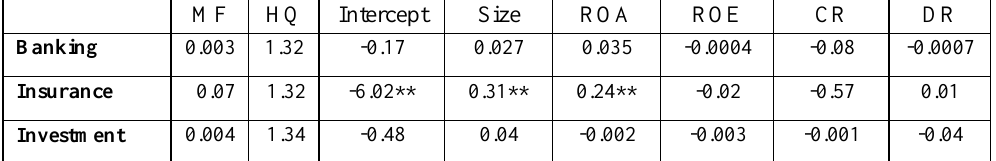
Table 6: Effect of firm characteristics on jump beta